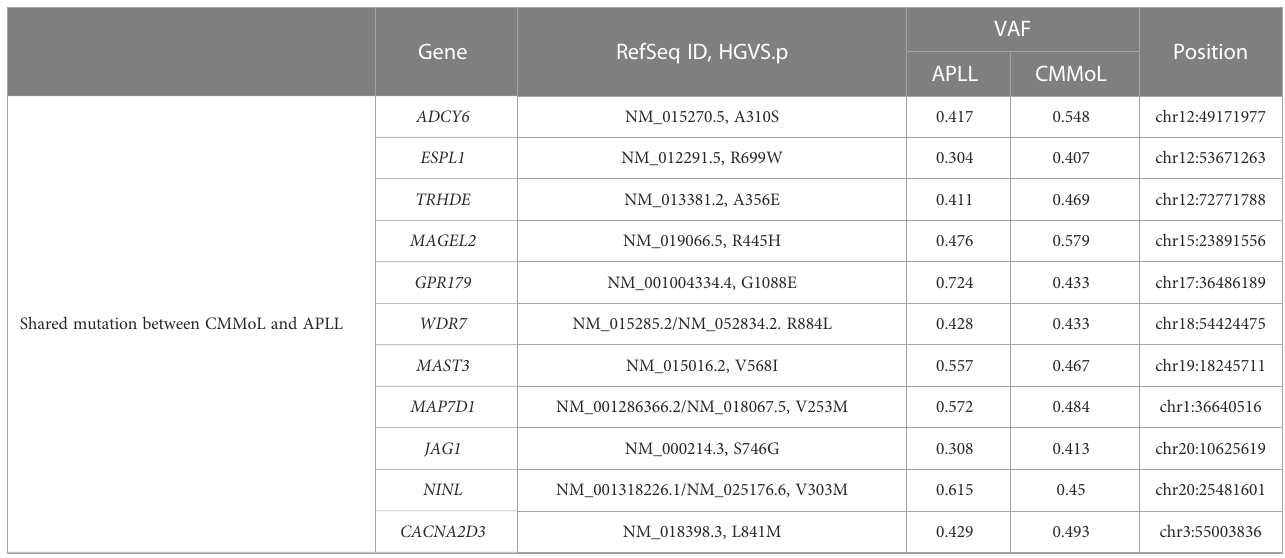
TABLE 1 Single nucleotide variants detected in CMMoL and/or APL-like leukemia samples.